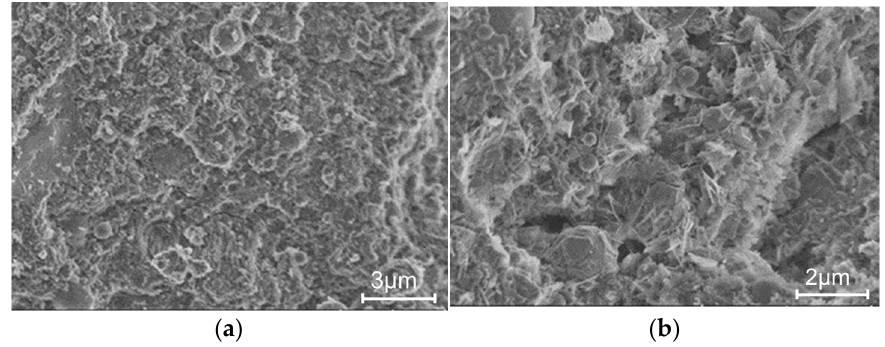
Figure 13. Morphology of 2.0 kg/m 3 cement sample: ( a ) non-corroded; ( b ) corroded.